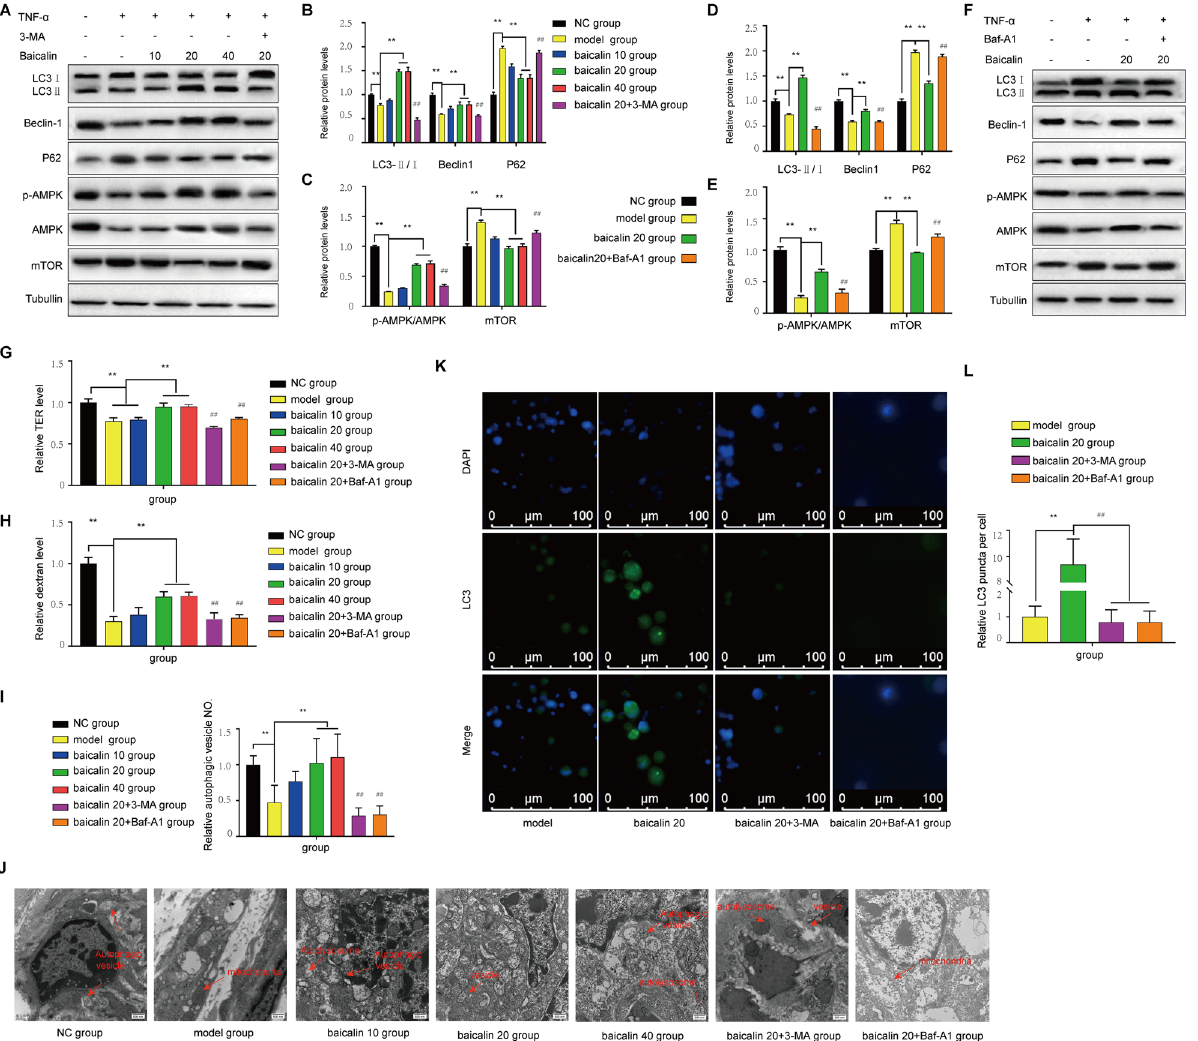
Figure 4. Caco2 cell experiment. ( A ) Measurement of the levels of the autophagy-related proteins LC3II/I, Beclin1, P62, p-AMPK, AMPK, and mTOR by Western blotting after treatment with or without 3-MA. ( B ) Analysis of the LC3II/I, Beclin1 and P62 protein levels. ( C ) Analysis of the p-AMPK, AMPK, and mTOR levels. ( D ) Analysis of the LC3II/I, Beclin1 and P62 protein levels after treatment with or without Baf- A1 to inhibit autophagy. ( E ) Analysis of the p-AMPK, AMPK, and mTOR levels. ( F ) Measurement of the levels of the autophagy-related proteins LC3II/I, Beclin1, P62, p-AMPK, AMPK, and mTOR by Western blotting after treatment with or without Baf-A1. ( G ) Measurement of the permeability of Caco-2 cells. ( H ) Assessment of the dextran level in each group. ( I ) Assessment of autophagic vesicle numbers. ( J ) Observation of autophagic vesicles by TEM. ( K ) Immunofluorescence staining for LC3 in different groups. ( L ) Assessment of immunofluorescence staining for LC3. All the blots are representative cropped images and every set was processed simultaneously under similar conditions. Representative original blots with cropped demarcations ( A ) are provided in Supplementary Fig. 2. Every experiment was repeated in triplicate. * P < 0.05 and ** P < 0.01 compared with the model group. ## P < 0.01 compared with the 20 mg/(kg d) baicilin